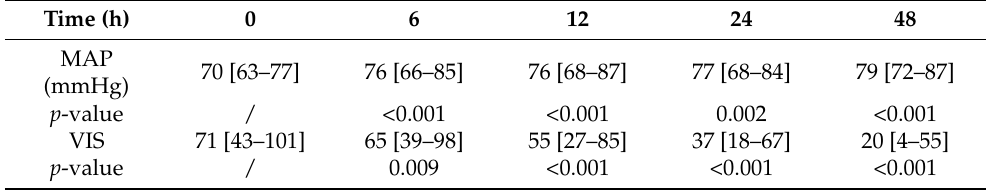
Table 3. Hemodynamic and laboratory parameters from the beginning of CytoSorb treatment to 48 h after the start of the first CytoSorb treatment. Values presented as median, interquartile range, statistical comparison to time